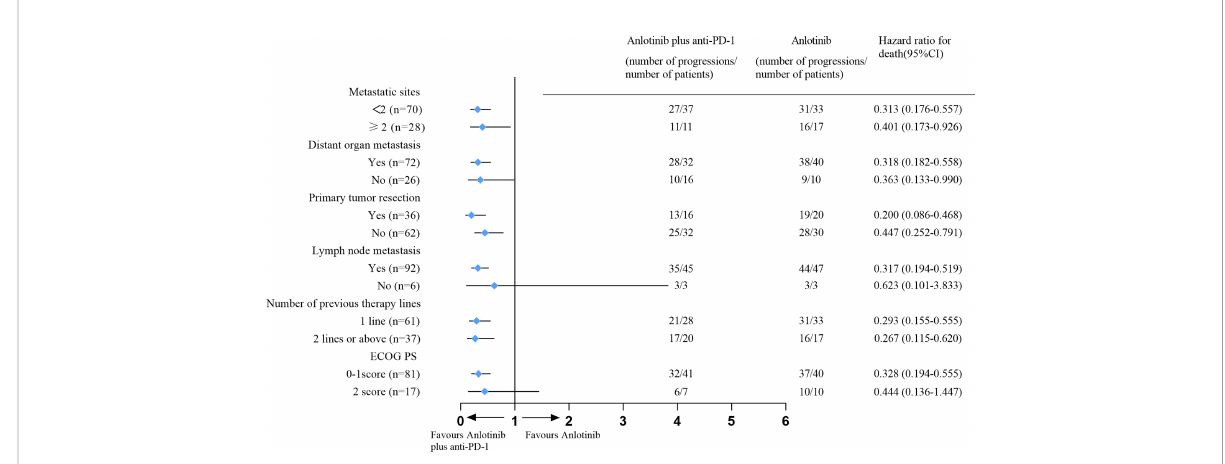
FIGURE 7 Forest plot for subgroup analysis of PFS. Hazard ratios and the corresponding 95% CIs for anlotinib plus PD-1 blockade relative to anlotinib monotherapy were calculated using the Cox proportional hazards mode. PFS, Progression-Free Survival; PD-1blockade, Programmed death-1 blockade; ECOG PS, Eastern Cooperative Oncology Group Performance